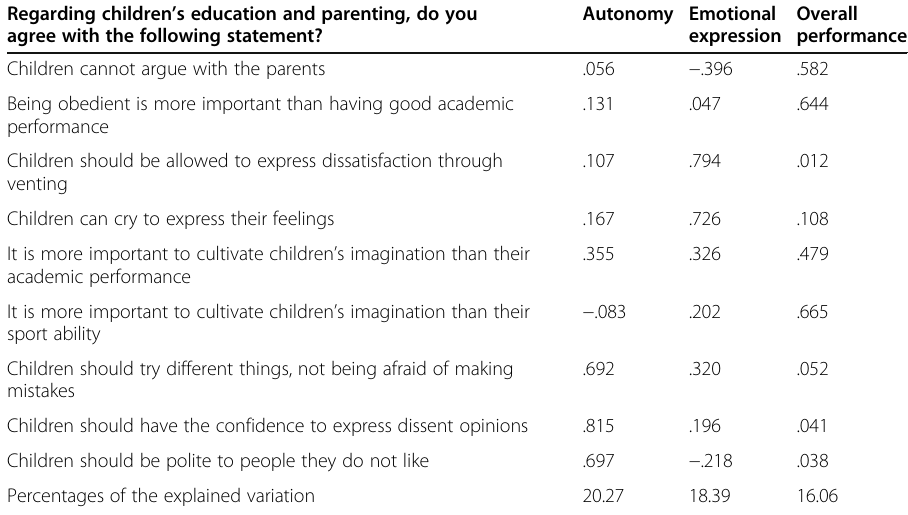
Table 2 Factor loadings of skill building in the SHFS 2010 (principal component analysis) Regarding children ’ s education and parenting, do you agree with the following